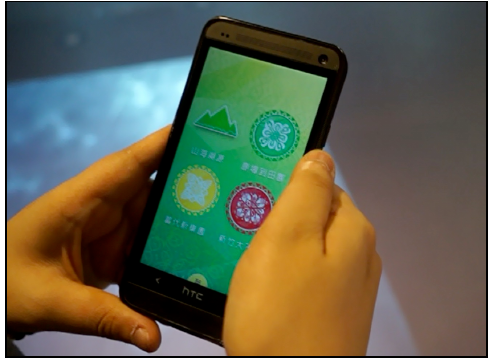
Figure 9. The UI is designed with vivid colour and icons